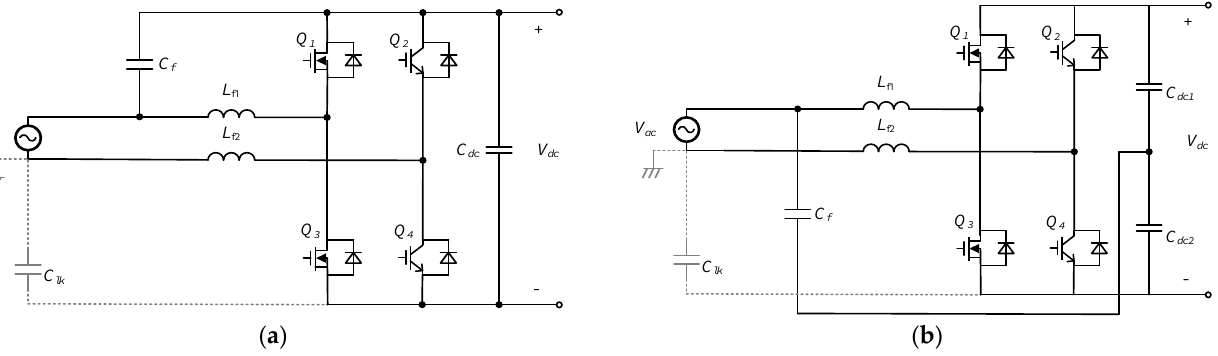
Figure 8. Possible configurations of the single-phase bidirectional transformerless PFC. ( a ) C f con- necting to V dc plus and ( b ) C f half V dc minus.